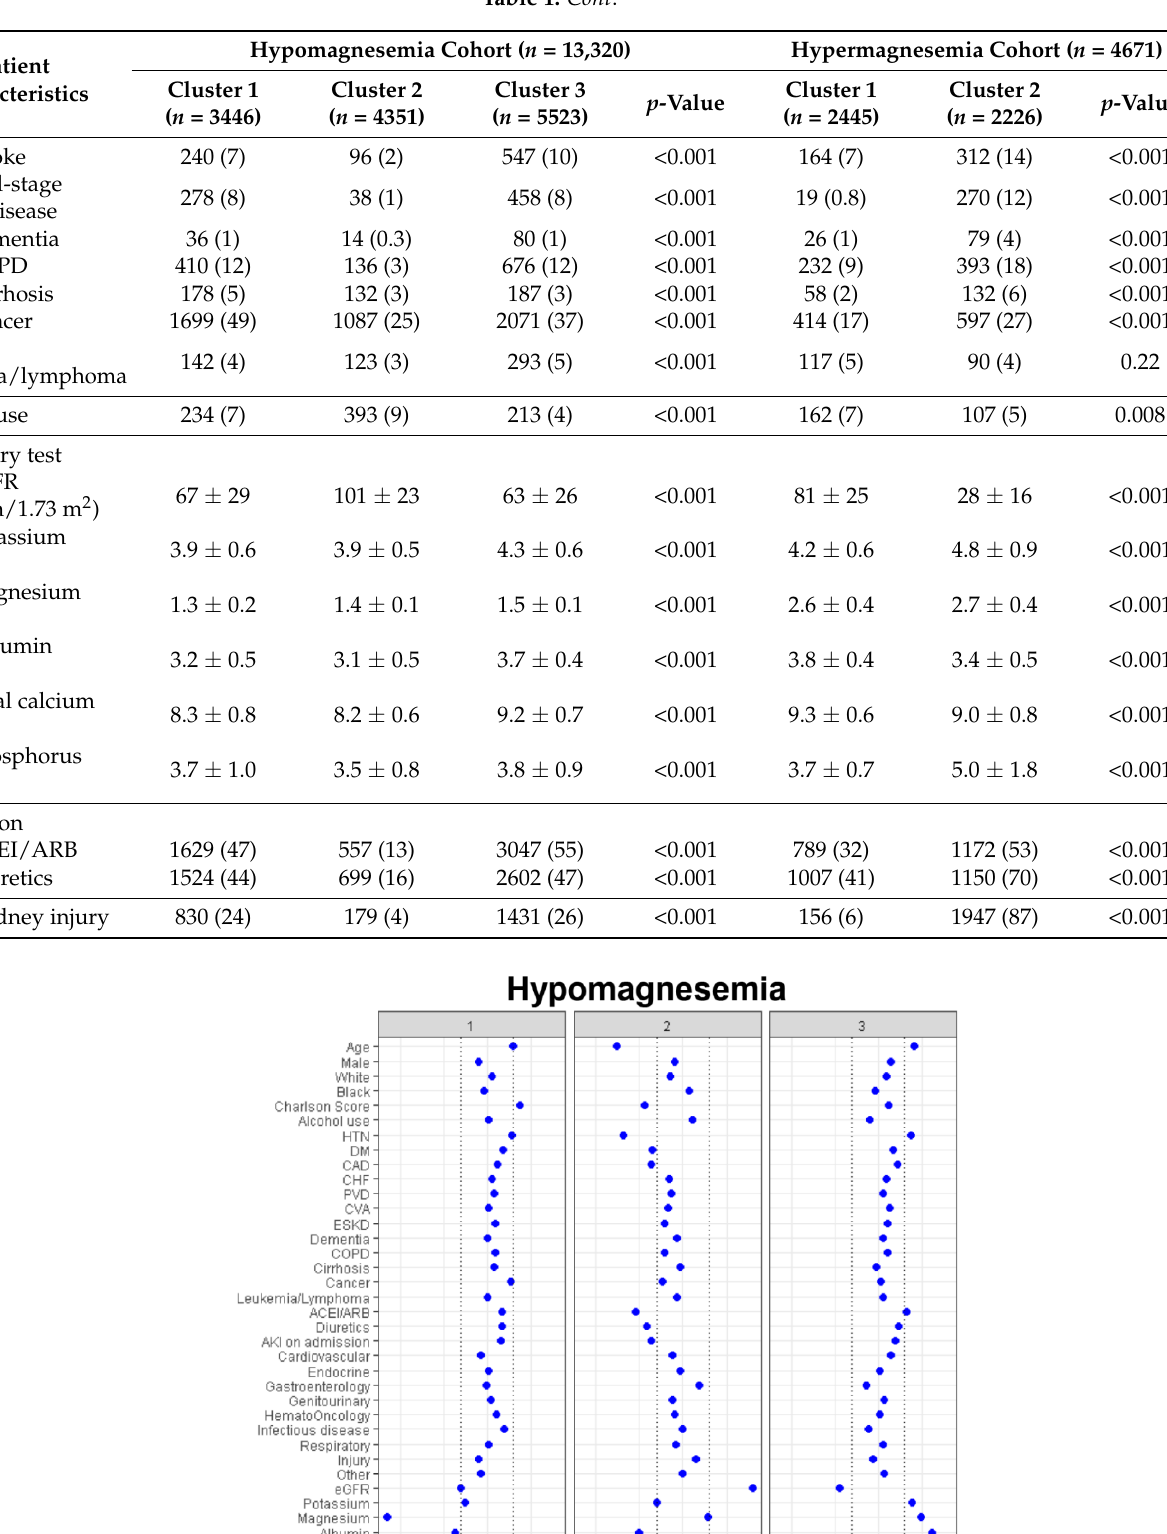
Figure 4. The standardized differences across three clusters for each of baseline parameters for pa- tients with hypomagnesemia and hypermagnesemia. The x -axis represents the standardized differ- ences value, and the y axis represents baseline variables. The dashed vertical lines signify the stand- ardized differences cutoffs of < − 0.3 or >0.3. Abbreviations: AG, anion gap; AKI, acute kidney injury;